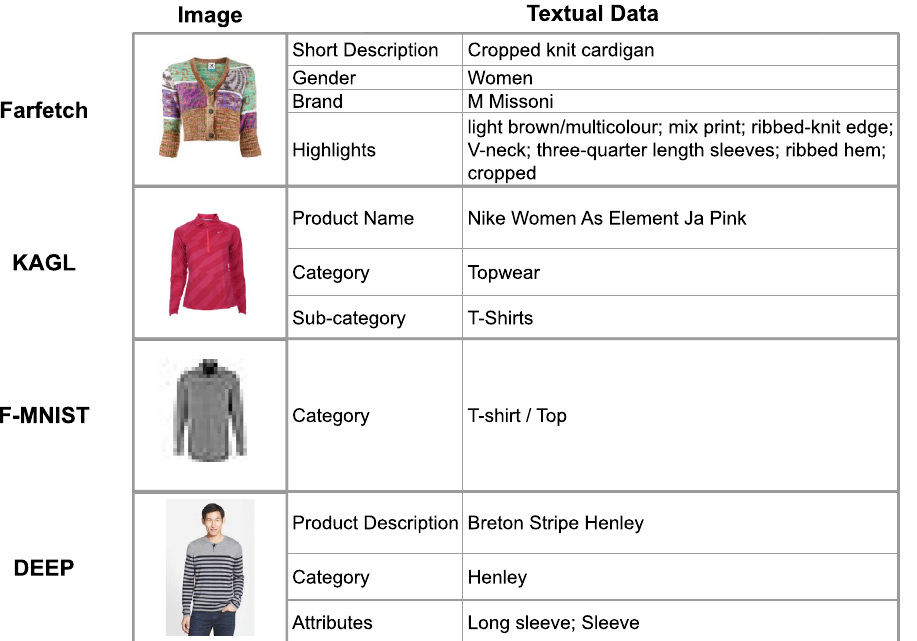
Figure 3. Sample of data from various datasets used. We observe a range of distributions on both the image and textual modalities. For the image modality, we see a range from “Low resolution, B &W” to “High resolution, In-the-Wild”. For the textual modality, Farfetch offers the best “textual resolution”, while DEEP also has very fashion specific terminology. The KAGL , F-MNIST , and DEEP datasets are publicly available. For more details regarding the data, see the Data Availability Section.